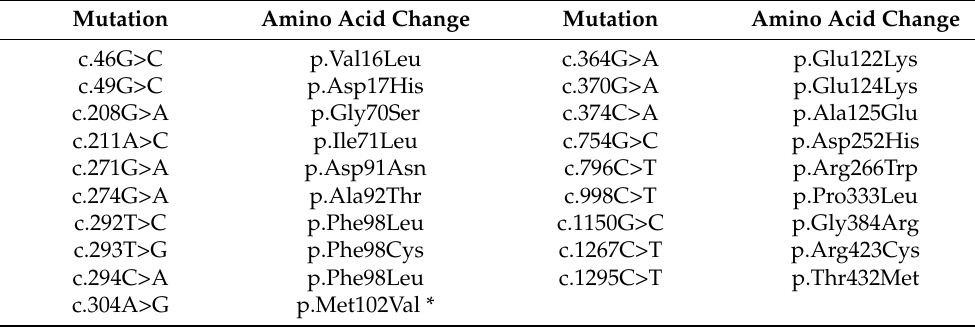
Table 2. De novo missense mutations in the human EEF1A2 gene and corresponding amino acid replacements in eEF1A2 that have been associated with severe neurological disorders, including epilepsy and intellectual disabilities in children [34,86,88,93] and cardiomyopathies [90,91]. Mutation Amino Acid Change Mutation Amino Acid Change